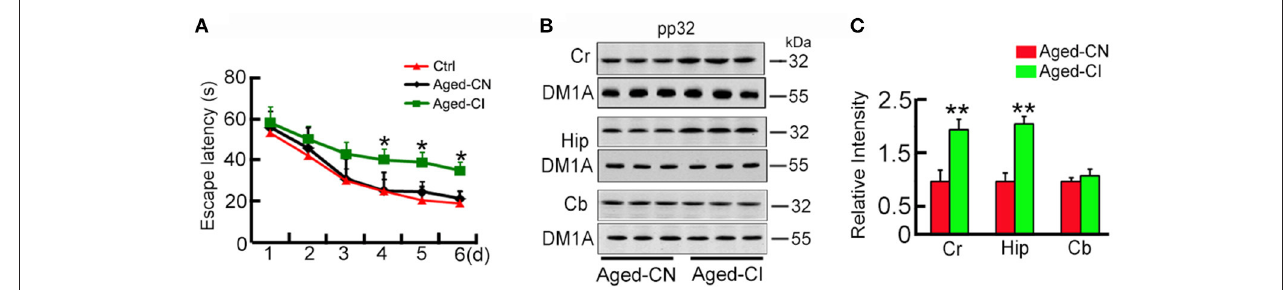
FIGURE 1 | Pp32 level increases in the hippocampus of aged cognitive-impaired mice. (A) Escape latency in the Morris water maze task of 12 m-old (Ctrl, n = 9), cognition-normal 18 m-old C57 mice (Aged-CN, n = 9) and cognitive-impaired 18 m-old C57 mice (Aged-CI, n = 9).* p < 0.05 vs. Ctrl (mean ± SEM). (B,C) .Western blotting analysis (B) and quantification (C) of pp32 levels in the cortex (Cr), hippocampus (Hip) and cerebellum (Cb) of Aged-CN and Aged-CI mouse brain ( n = 3 for each group). Tubulin was used as a loading control and was detected with DM1A antibody. Note: pp32 levels are significantly increased in the Hip of Aged-CI, compared to that in Aged-CN. * p < 0.05, ** p < 0.01 vs.